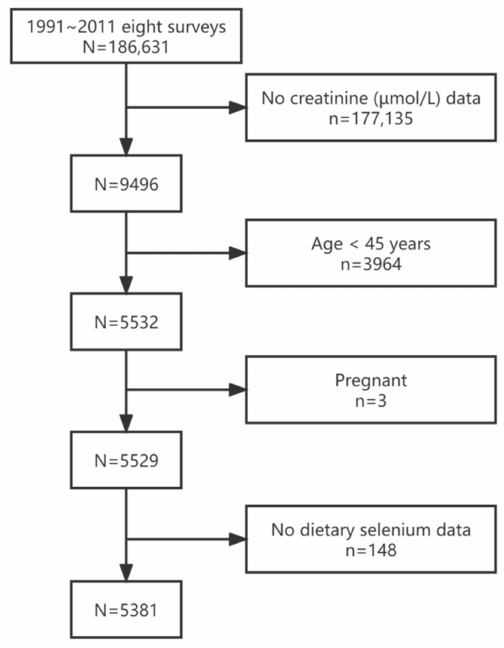
Figure 1. Participant flow